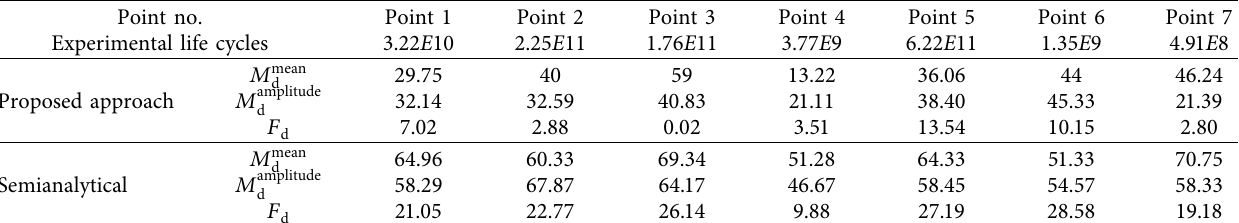
Figure 13: Cycle distributions of ε and ε : (a) and (b) at Point 1; (c) and (d) at Point 2; (e) and (f) at Point 3; (g) and (h) at Point 4; (i) and a mean (j) at Point 5; (k) and (l) at Point 6; (m) and (n) at Point 7. Table 3: Quality of the estimated strain